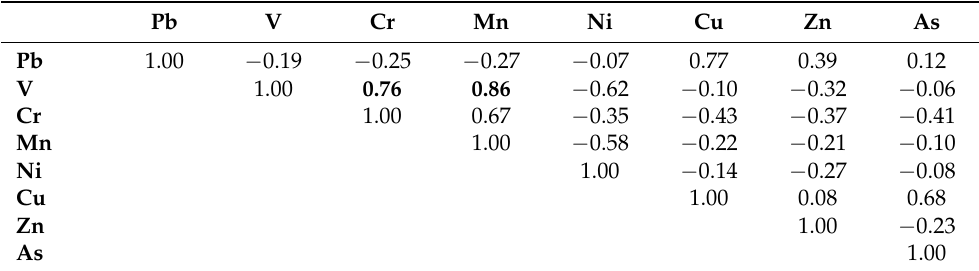
Table 2. Pearson’s correlation matrix among metals in FHA (N = 13; p < 0.05). Correlation coeffi- cients > 0.69 are indicated in bold.